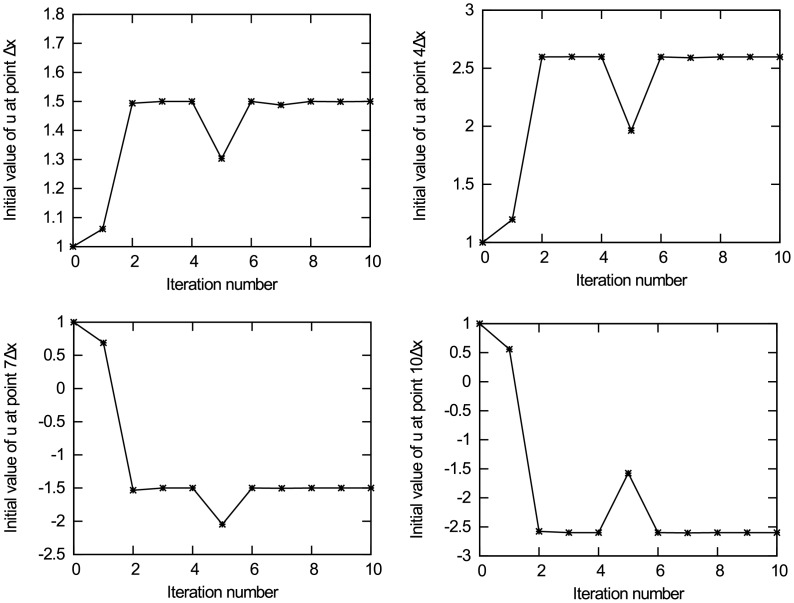
The change of initial state u0 with iteration number.(a) Initial state u0,Δx; (b) Initial state u0,4Δx; (c) Initial state u0,7Δx; (d) Initial state u0,10Δx.